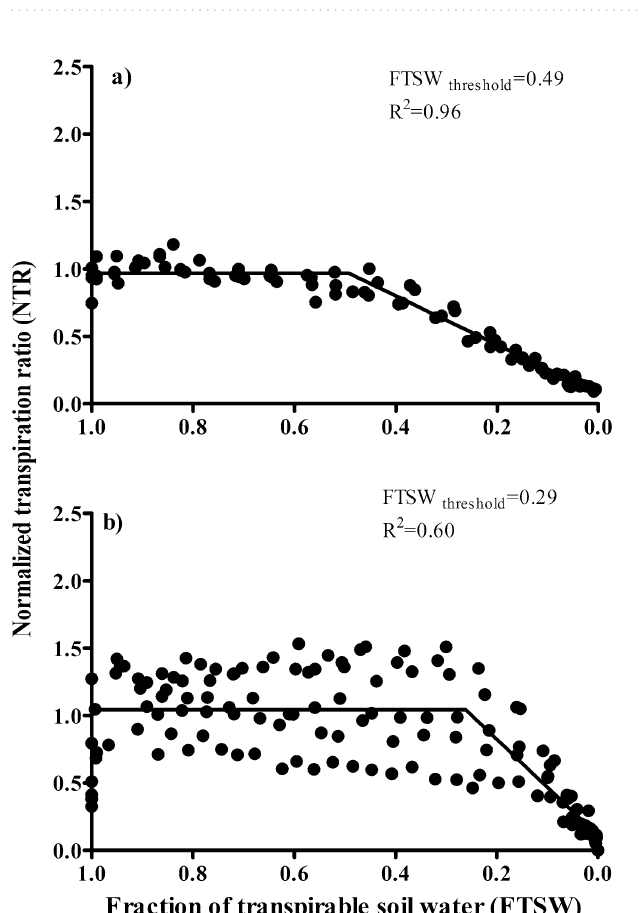
Figure 3. Normalized transpiration rate (NTR) of goosegrass [ Eleusine indica (L) Gaertn] in silt-loam ( a ) and silica-sand ( b ) subjected to a drying cycle plotted against the fraction of transpirable soil water during progressive soil drying experiments conducted in a greenhouse located at the West Tennessee AgResearch and Education Center (Jackson, TN) during